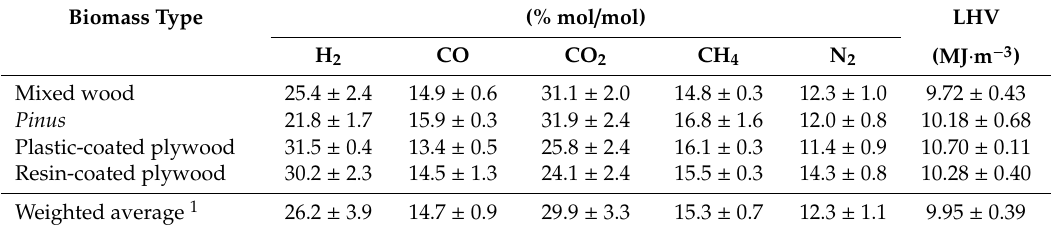
Table 7. Gaseous fuel composition for the 800 ◦ C